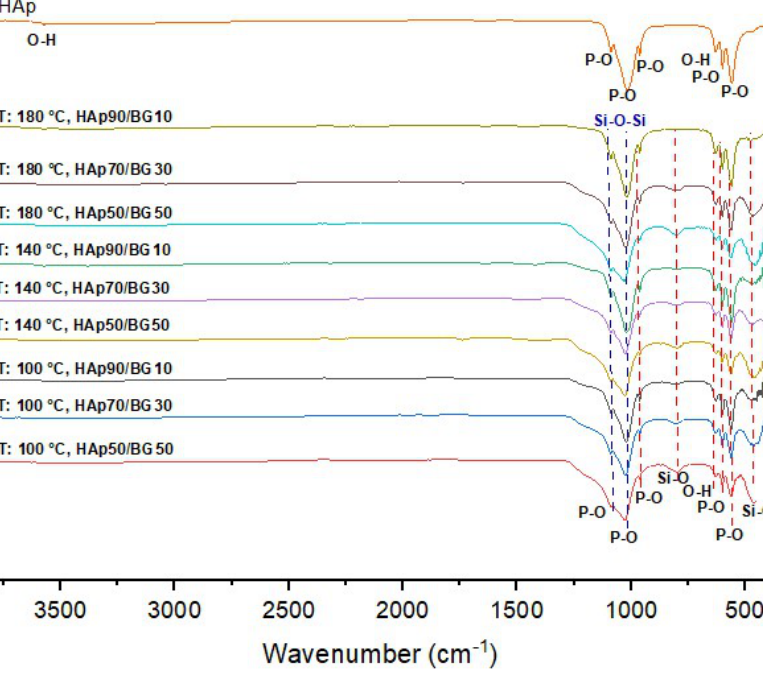
Figure 4. FTIR spectra of HAp and HAp/BG nanocomposites under different conditions based on DOE.